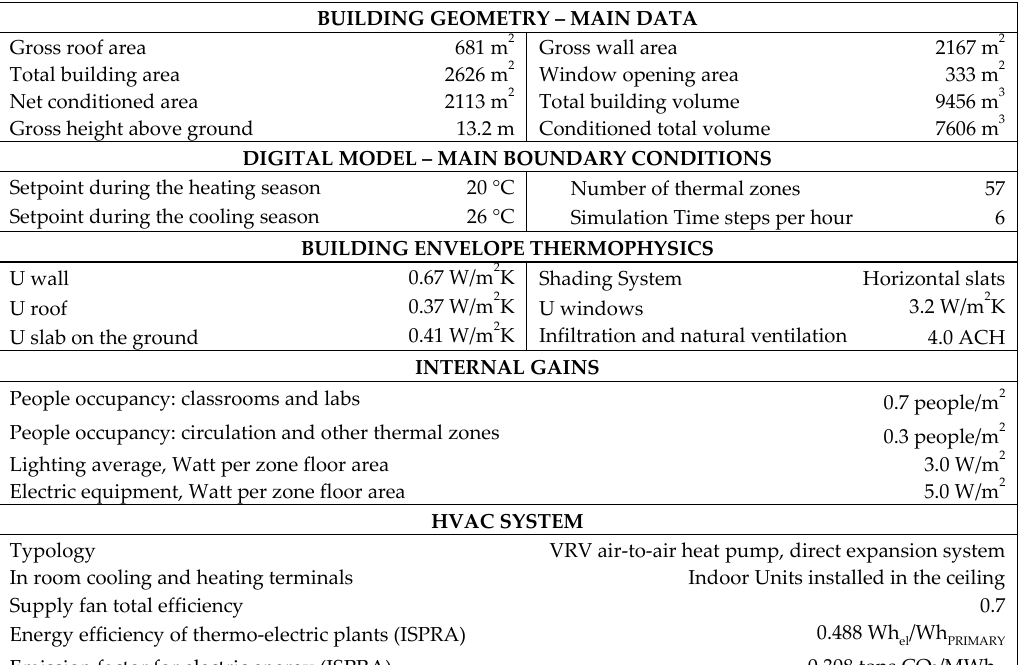
Figure 2. Geometrical 3D model (Design Builder) and realistic view (Revit Architecture). Table 2. Information data for the building modelling.